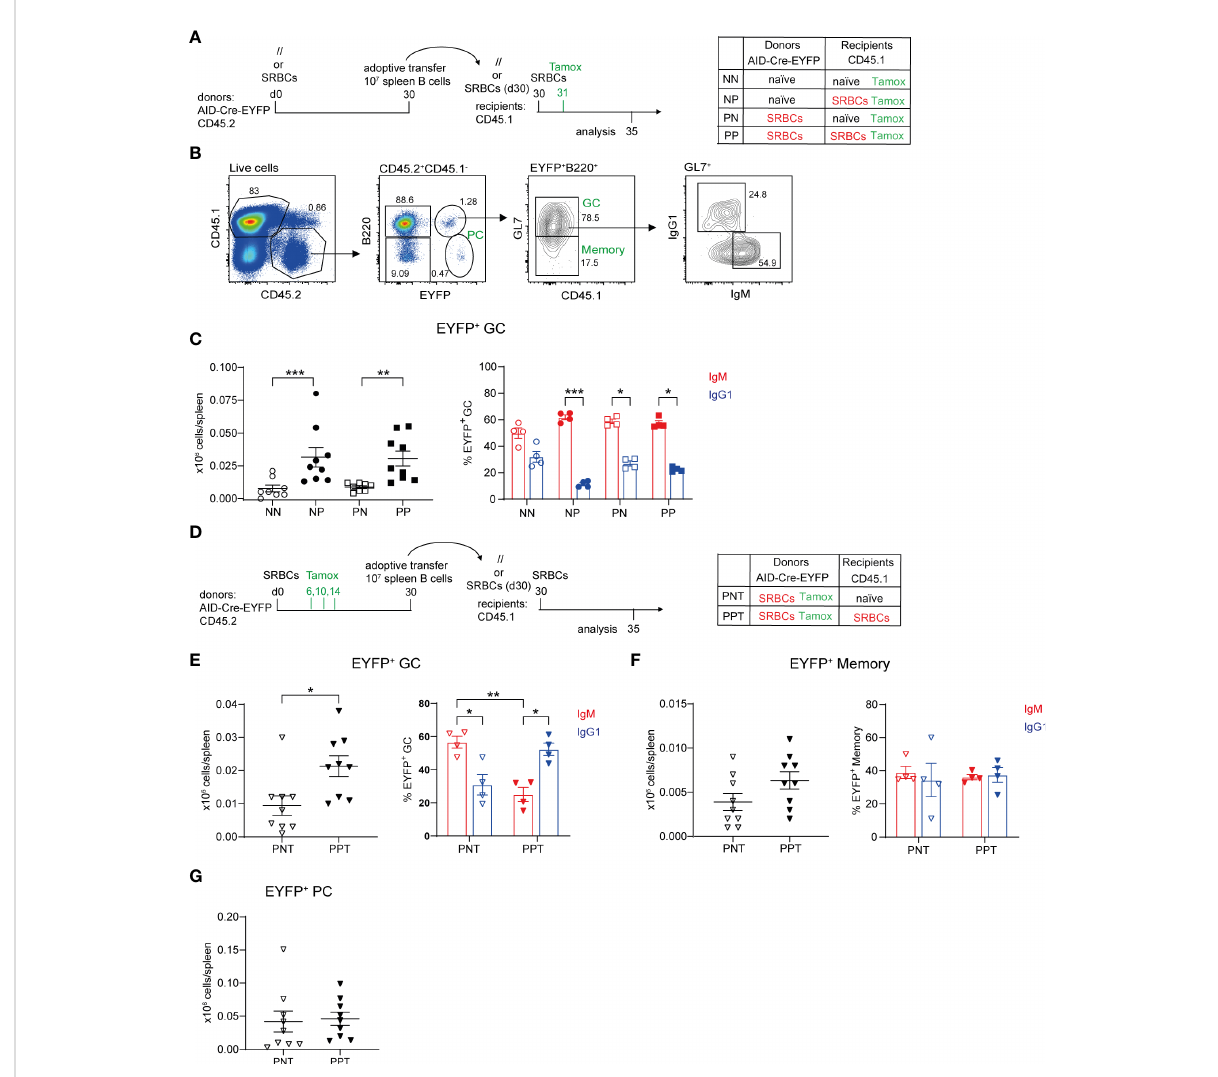
FIGURE 2 Contribution of naive and antigen-experienced B cells to secondary GC reactions. (A) 10 x10 6 total puri fi ed splenic B cells from naive (//) or SRBC-primed AID-Cre-EYFP donor mice (d30) were adoptively transferred into naive or primed (d30) wt CD45.1 recipient mice. Host mice were injected with SRBCs 2 hours after adoptive cell transfer and received tamoxifen the following day. Spleens from recipient mice were analyzed 5 days after SRBC challenge. (B) CD45.1 - CD45.2 + donor cells from recipient spleens were gated into B220 + EYFP + cells and then EYFP + GL7 +